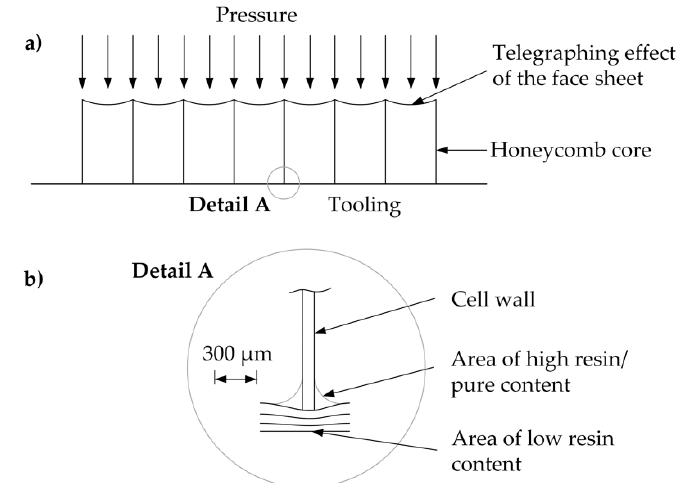
Figure 13. ( a ) Telegraphing effect of thin layers on top of a honeycomb core; ( b ) waviness in tool side face layers due to non-uniform consolidation pressure.